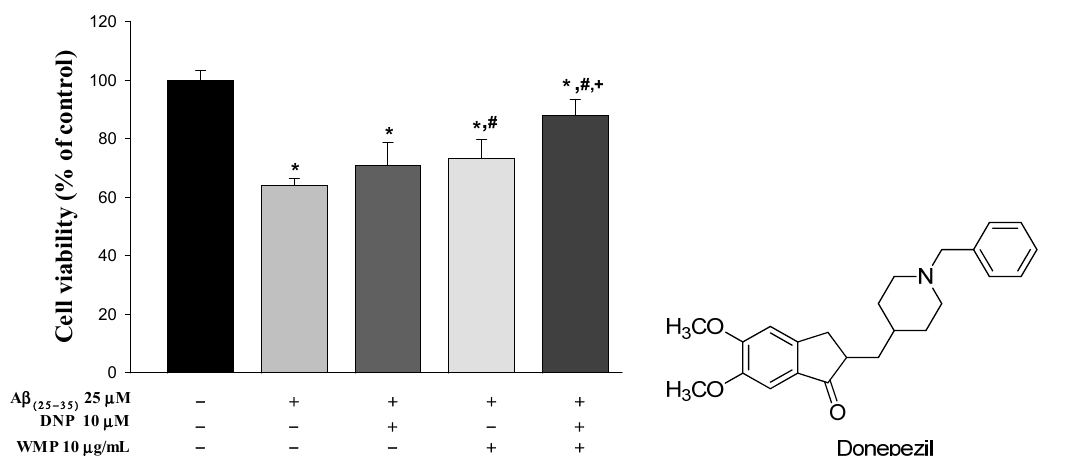
Figure 1. Effect of WMP and DNP combination on A β (25–35) -induced neurotoxicity in SH-SY5Y neuroblastoma cells. Each value represents the mean ± S.E.M. from at least three independent experiments. * p < 0.05 v.s. vehicle-treated control group; # p < 0.05, vs. A β (25–35) group; and + p < 0.05, DNPWMP was significantly different from other groups, respectively.